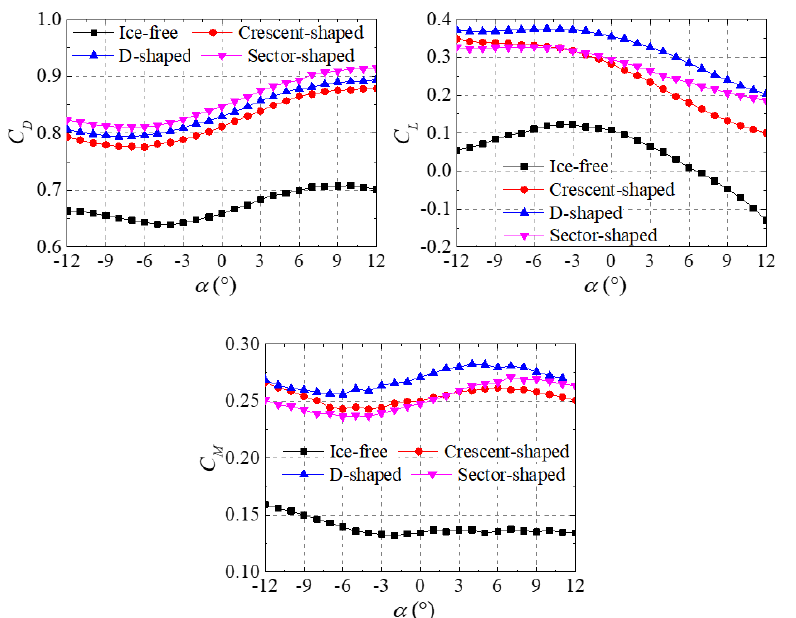
Figure 26. Aerodynamic force coefficients of section with various ice types for C4 ice class ( U = 15.5 m/s).